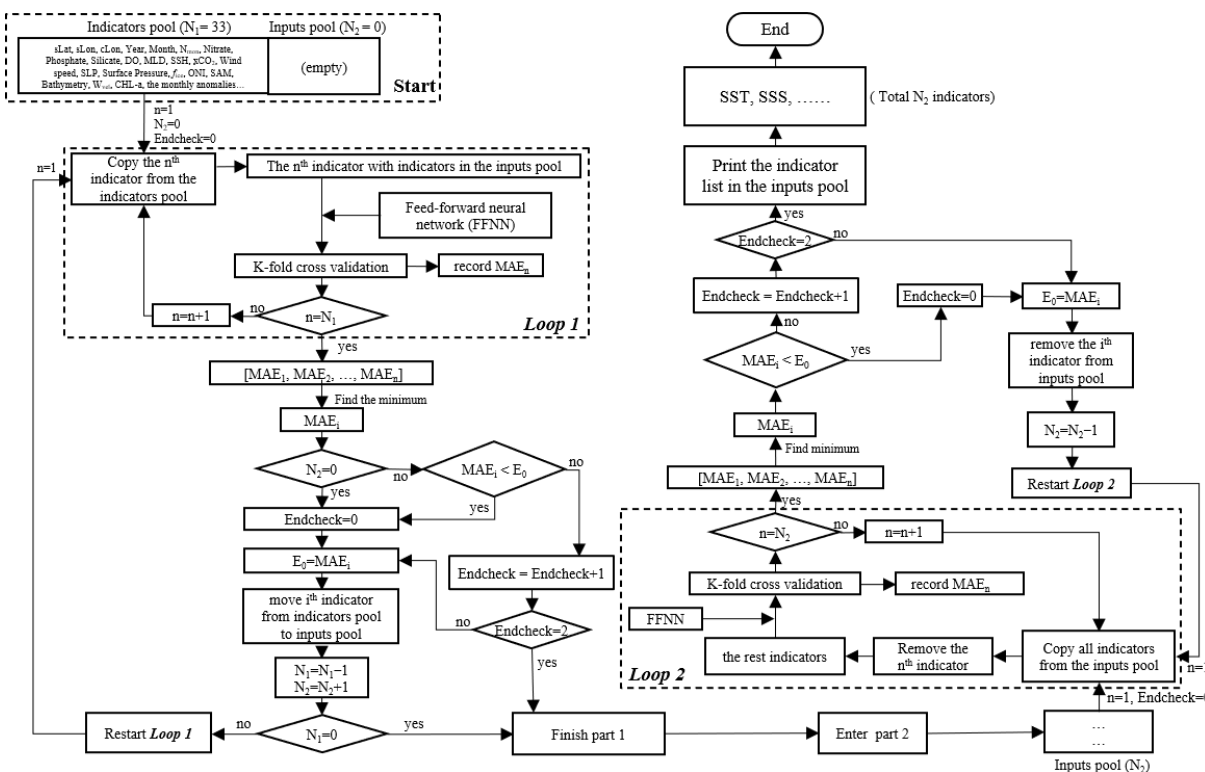
Figure 2. The procedure of the stepwise FFNN algorithm. The flowchart follows an order of top left–bottom left–bottom right–top right. The meaning of Predictors pool : store all predictors waiting to be tested; Inputs pool : store predictors that were temporally considered as good predictors; Loop 1 and Loop 2 : calculate the MAE when each predictor was added or removed; Selection step : add good predictors to the Inputs pool ; Removal step : remove predictors from the Inputs pool if removing leads to MAE decrease; Determine step : check if the process reaches end condition. N 1 and N 2 : number of predictors in the Predictors pool and Inputs pool , respectively; E 0 : lowest MAE in the last iteration of Loop 1 or Loop 2 ; Endcheck : the number of iterations that E 0 continuously